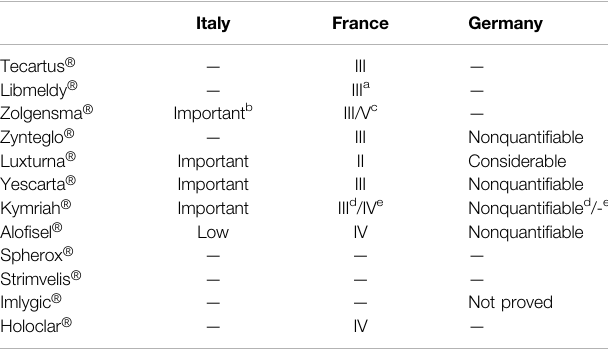
TABLE 4 | Agreement among opinions about therapeutically added value issued by member